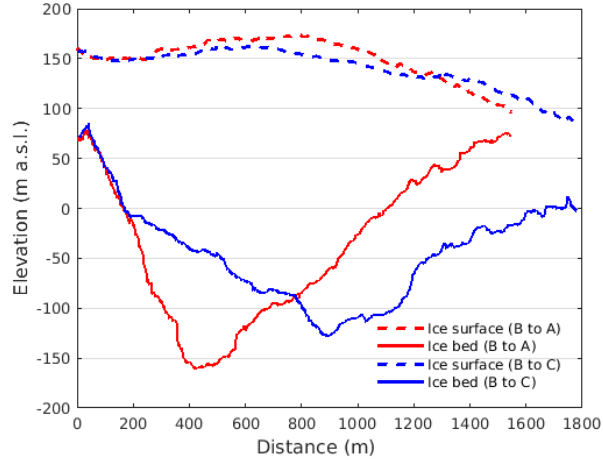
Figure 4. Ice surface and glacier bed elevation along the profiles shown in Fig.